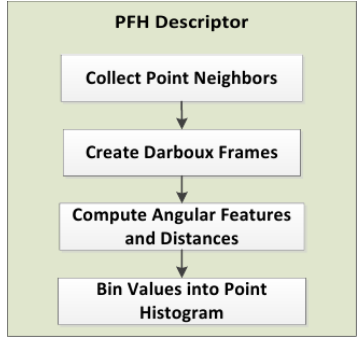
Figure 7: PFH descriptor computation for one point